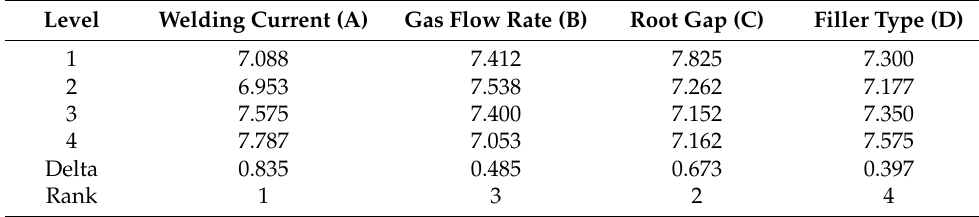
Table 20. Response table for means of Bead